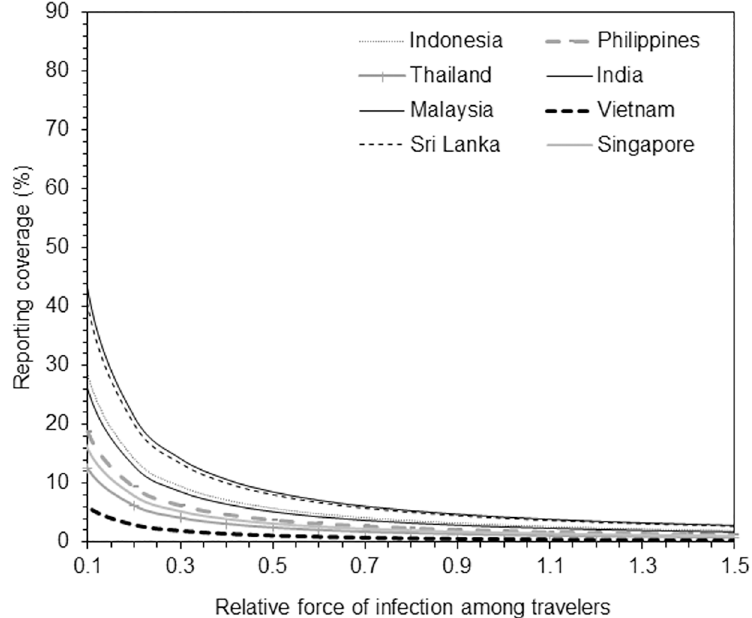
Fig 5. Sensitivity of reporting coverage to the relative hazard of travelers compared with local population. Relative hazard on horizontal axis shows the relative hazard, obtained as the ratio of the force of infection among Japanese travelers to that of the local population in each destination country. Vertical axis measures the estimated reporting coverage; only maximum likelihood estimates are shown.